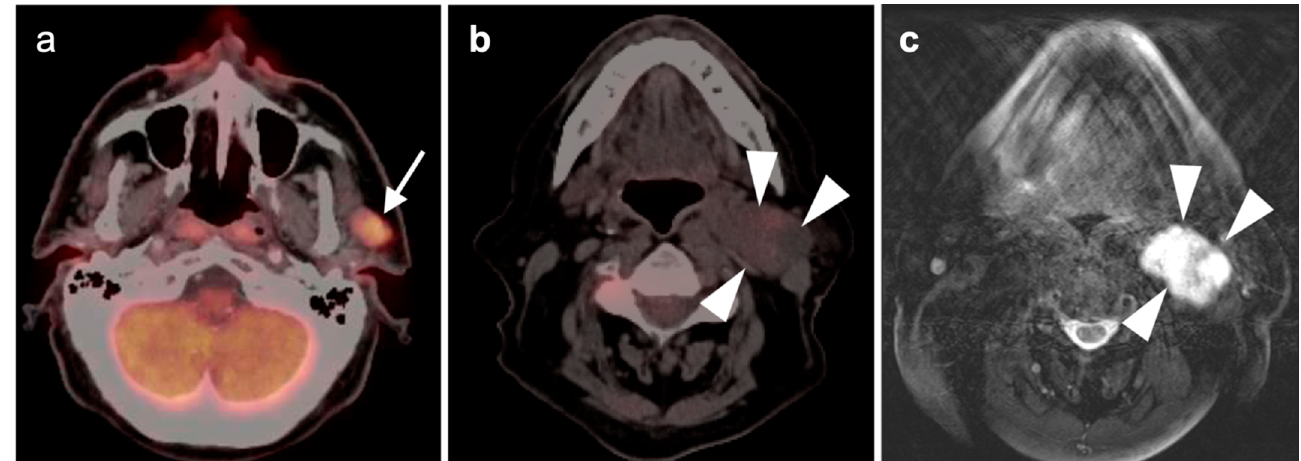
Figure 25. Pleomorphic adenomas, small and large. ( a ) A small left parotid pleomorphic adenoma is strongly hypermetabolic (white arrow). ( b , c ) A large pleomorphic adenoma of the left parotid is low in metabolic activity on FDG PET ‐ CT (white arrowheads), ( b ), but is typically bright on T2 MRI (white arrowheads), ( c ).